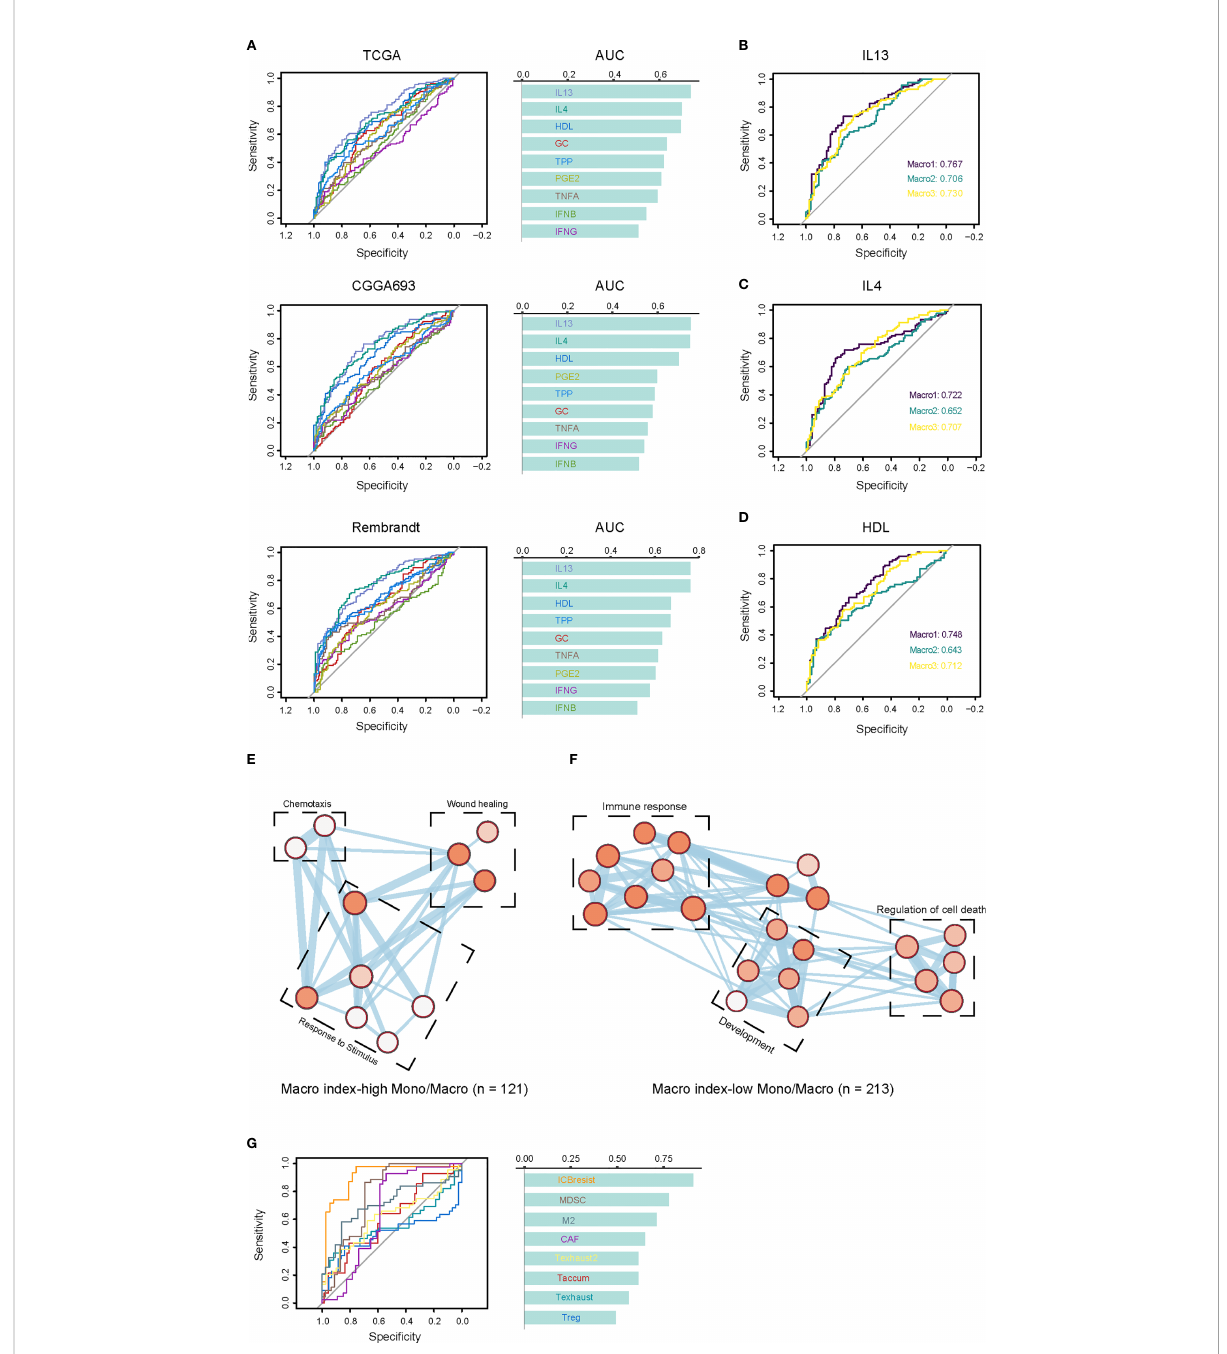
FIGURE 5 Association between the Macro index and the TAM phenotypes. (A) The consistency between the Macro index and gene signatures of TAM phenotype. Cells stimulated with GMCSF for 72 hours were M0 macrophages, and positive cells are cells cultured for 72 hours under different conditions after GMCSF-induced differentiation. Genes de fi ned as positive or negative hits were the top 150 up- or down-regulated in the positive vs. M0 group, respectively. The ROC curves measure the performance of the Macro index in the prediction of the positive or negative hit genes based on the signi fi cant Spearman rho of the two. (B-D) The ef fi ciency Macro index in predicting positive and negative hit genes induced by IL13, IL4, and HDL in each group. (E, F) Enrichment analysis of the biological processes of DEGs in Mono/Macro cells of the Macro index-high and Macro index-low groups. The color of the bubbles is inversely proportional to the q value of the enrichment score. (G) The prediction of T cell dysfunction-related gene signatures by the Macro